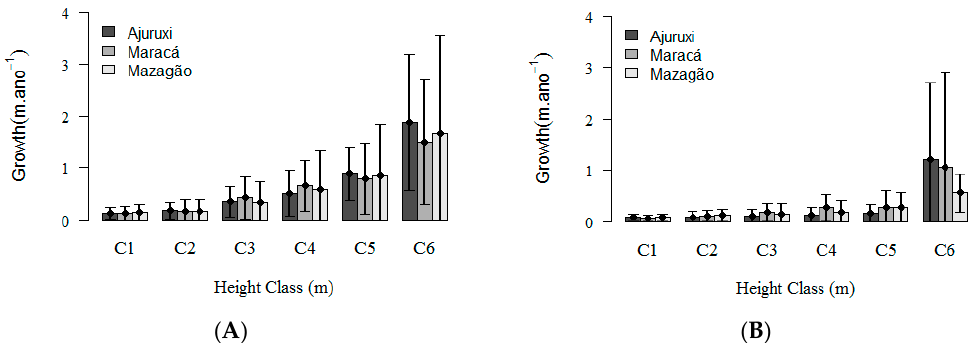
Figure 2. Average growth of the natural regeneration of Mora paraensis , in the southeast of Amapá, Brazil, eastern Amazonia, in function of height classes—C1 (0.5–1.50 m); C2 (1.51–2.50 m); C3 (2.51–3.50